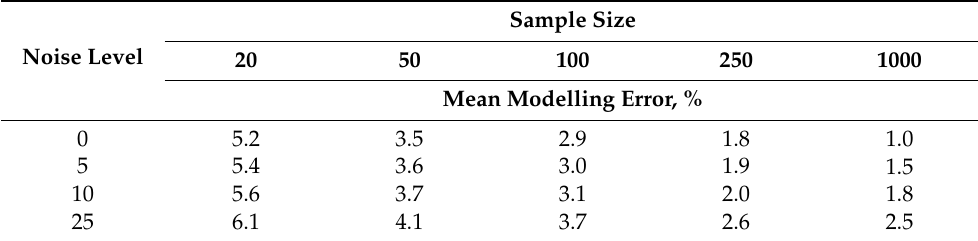
Table 4. Results of the study of nonparametric models by adjusting smoothing factors with a standard genetic algorithm (GA) on a test set.